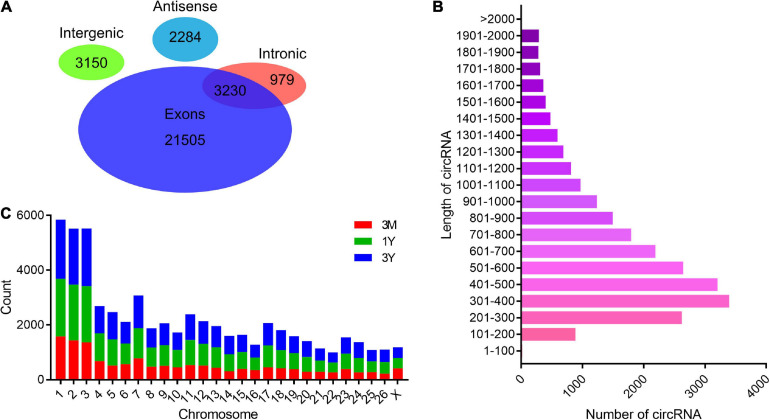
General features of circRNAs. (A) Venn diagram indicating that circRNAs numbers originated from different genomic sites. (B) Length distributions for the identified circRNAs. (C) Chromosome distribution map of circRNAs. 3M, 1Y, and 3Y refer respectively to 3-month-old, 1-year-old, and 3-year-old.